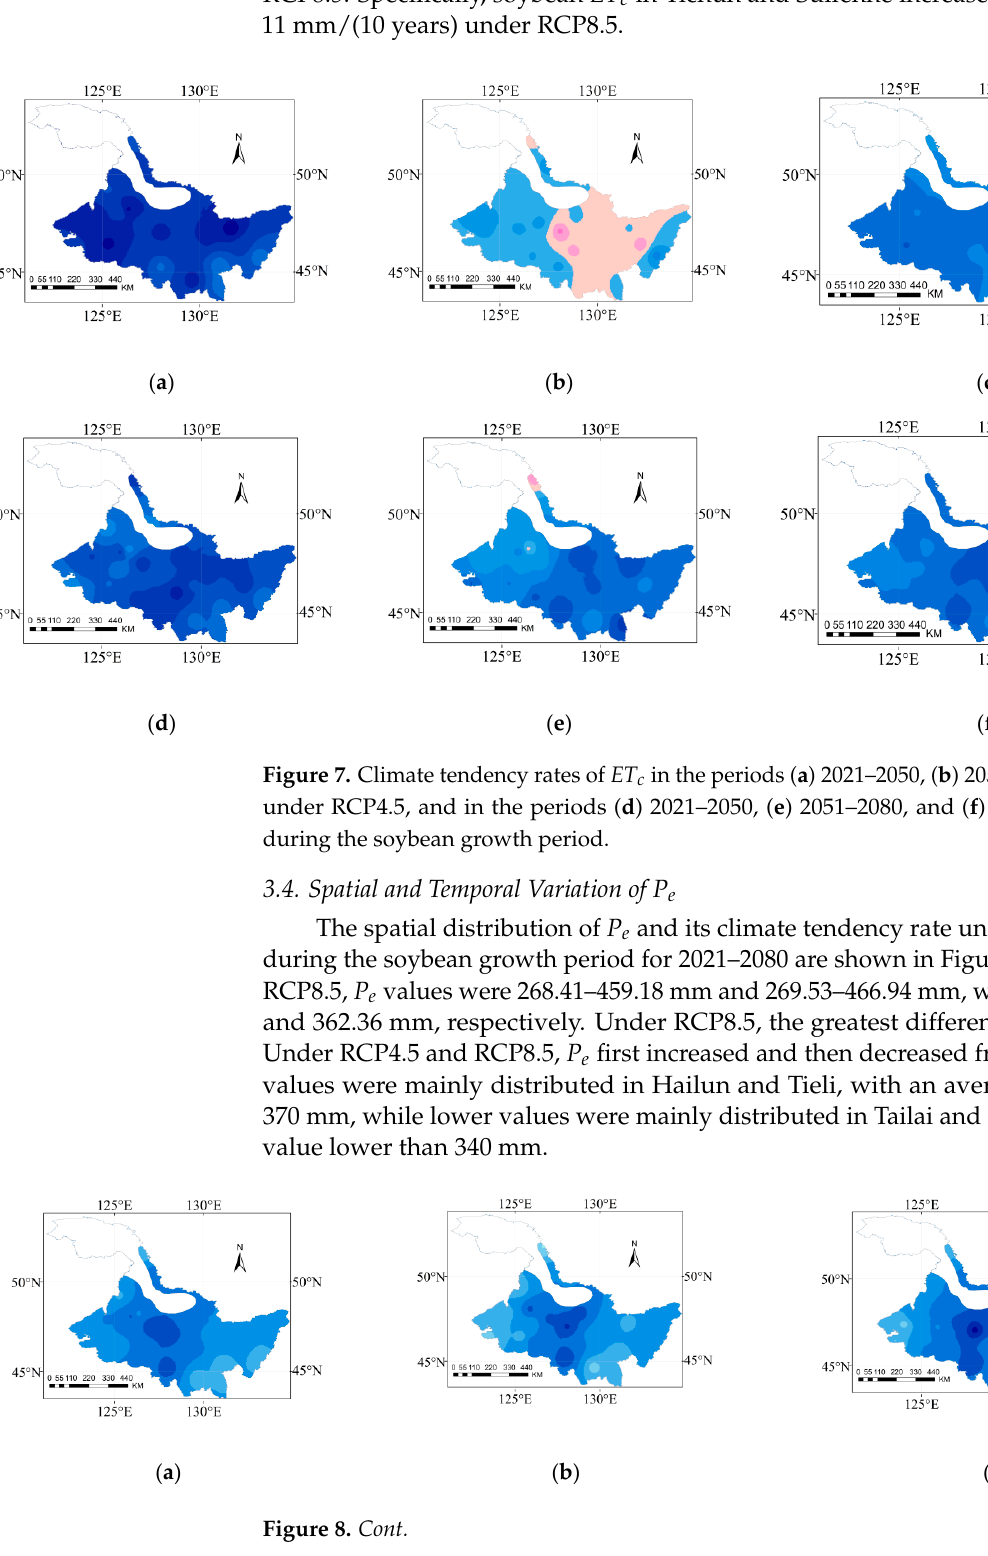
Figure 7. Climate tendency rates of ET c in the periods ( a ) 2021–2050, ( b ) 2051–2080, and ( c ) 2021– 2080 under RCP4.5, and in the periods ( d ) 2021–2050, ( e ) 2051–2080, and ( f ) 2021–2080 under RCP8.5 during the soybean growth period.